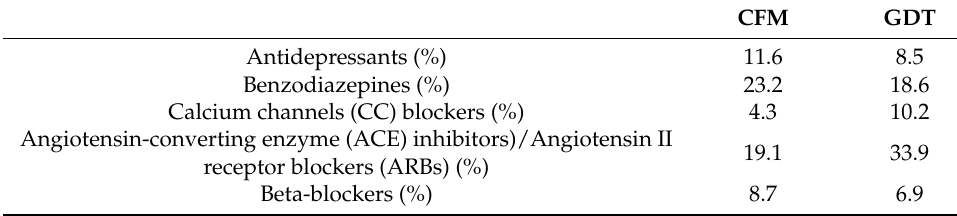
Table 3. Background therapy.